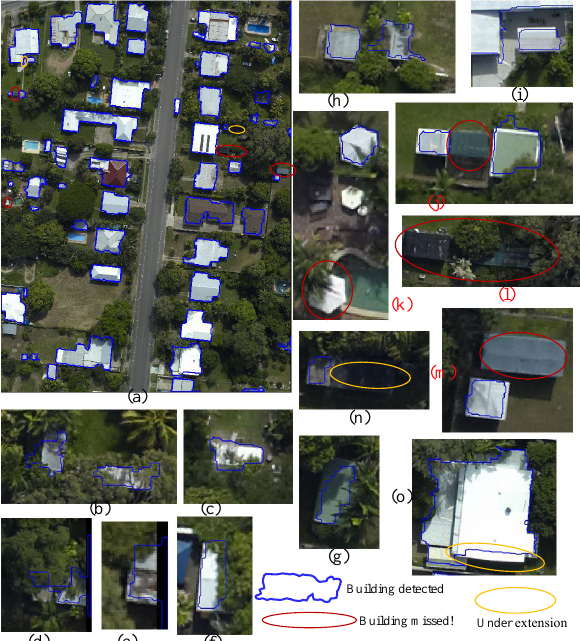
Figure 8. (a) Building detection on AV data set, (b)-(g) Magni- fied version of the buildings detected under complex scene, (h)-(i) Boundary over-extension, (j)-(m) Undetected buildings, (n)-(p) Boundary under-extension For quantitative analysis of proposed method, object-based eval- uation results are presented in Table 1, while pixel-based and ge- ometric evaluation results are given in Table 2, respectively.